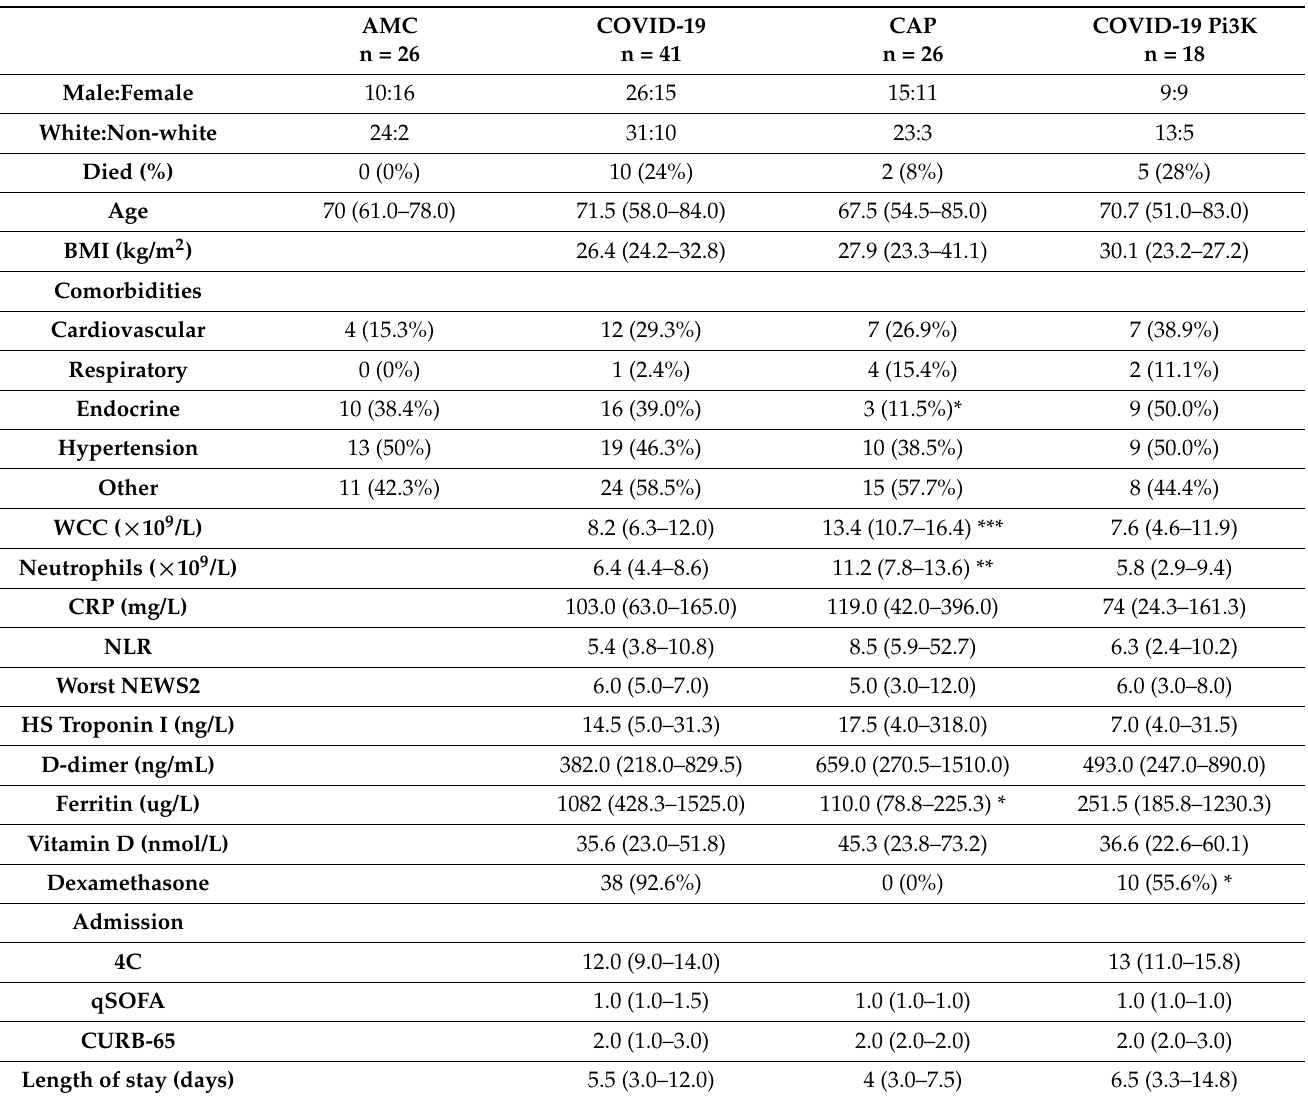
Table 1. Recruited patient demographics, collected at the time of enrolment. WCC- white cell count; CRP- C-reactive protein; NLR—neutrophil lymphocyte ratio; NEWS2—National Early Warning Score 2, data collected was worst score in the 24 h after admission; HS Troponin I—high sensitivity troponin I; qSOFA—quick Sepsis-related Organ Failure Assessment Score; CURB-65-Mortality in community acquired pneumonia. Comparisons were calculated between cohorts of COVID-19 patients and AMC, CAP or COVID-19 PI3K patients. * p < 0.05, ** p < 0.001, *** p < 0.0001. Normally distributed result shown with mean (SEM), not normally distributed shown with median (IQR Q1–Q3). Other comorbidities were included if they caused a significant impact on patient quality of life or regular medication—this included but was not limited to severe peripheral vascular disease with ulceration, dementia, chronic kidney disease, stroke, childhood polio, obesity, diverticulosis, alcohol related liver disease, or rheumatoid